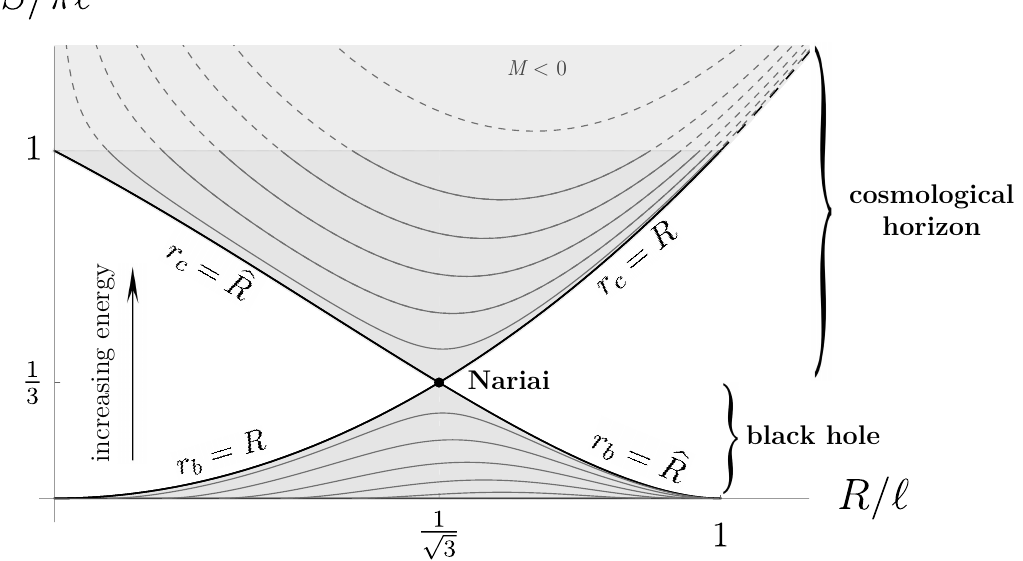
Figure 12. Entropy vs. the system boundary radius. Constant- E contours are shown, and the dashed curves correspond to negative mass parameter. The thick curves — intersecting at the Nariai point — indicate E = 0 , where either the black hole or the cosmological horizon radius coincides with the system boundary. The entropy increases as energy becomes larger, thus the temperature is positive for both black hole and cosmological horizon